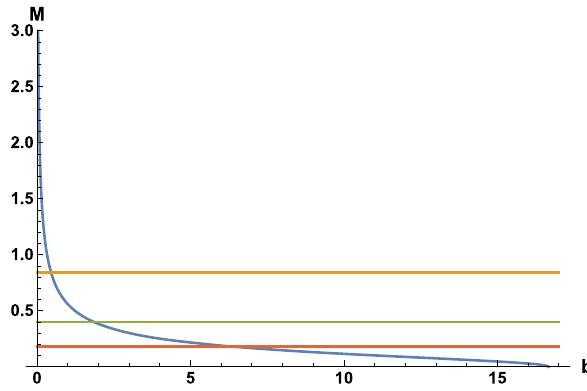
Fig. 2 Plotsofunstablemodes( • )onthreecurvesforsmallblackholes r + = 1 , 2 , 4 < r ∗ = 5 . 7 with l = 10. The y -axis denotes (cid:8) in e (cid:8) t , while the x -axis is the mass M . The smallest curve represents r + = 4, the medium denotes r + = 2, and the largest one shows r + =